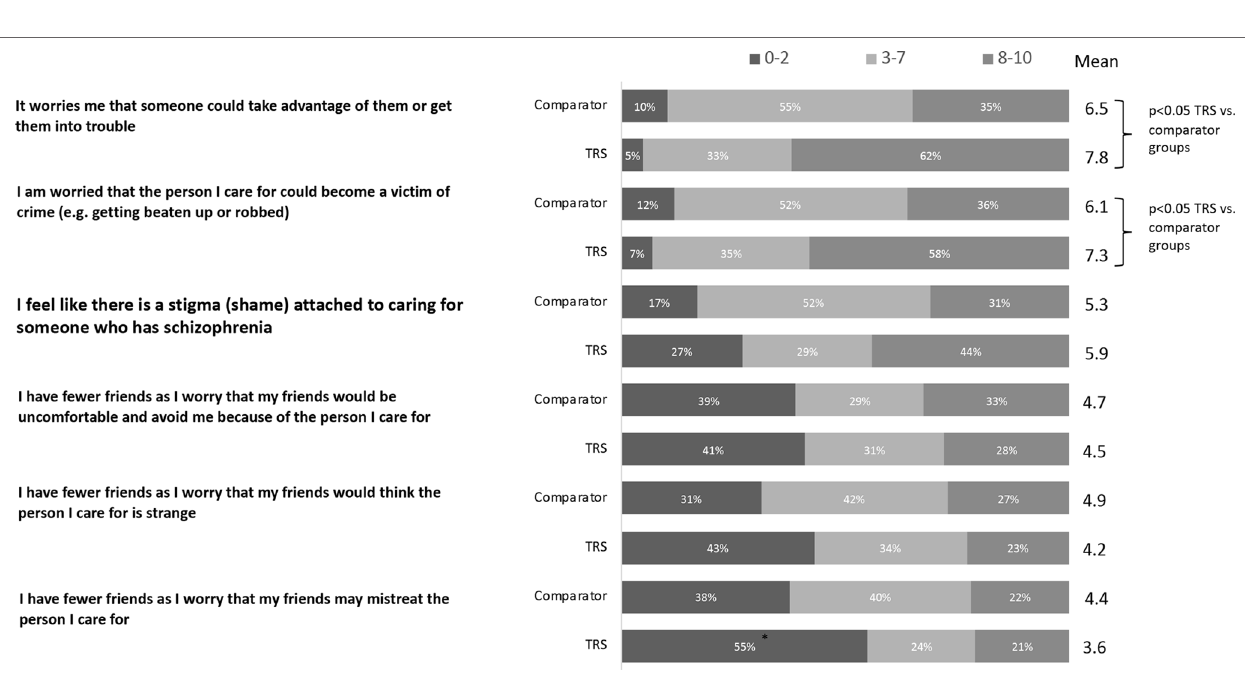
FIGURE 4 | Types of emotional care provided by